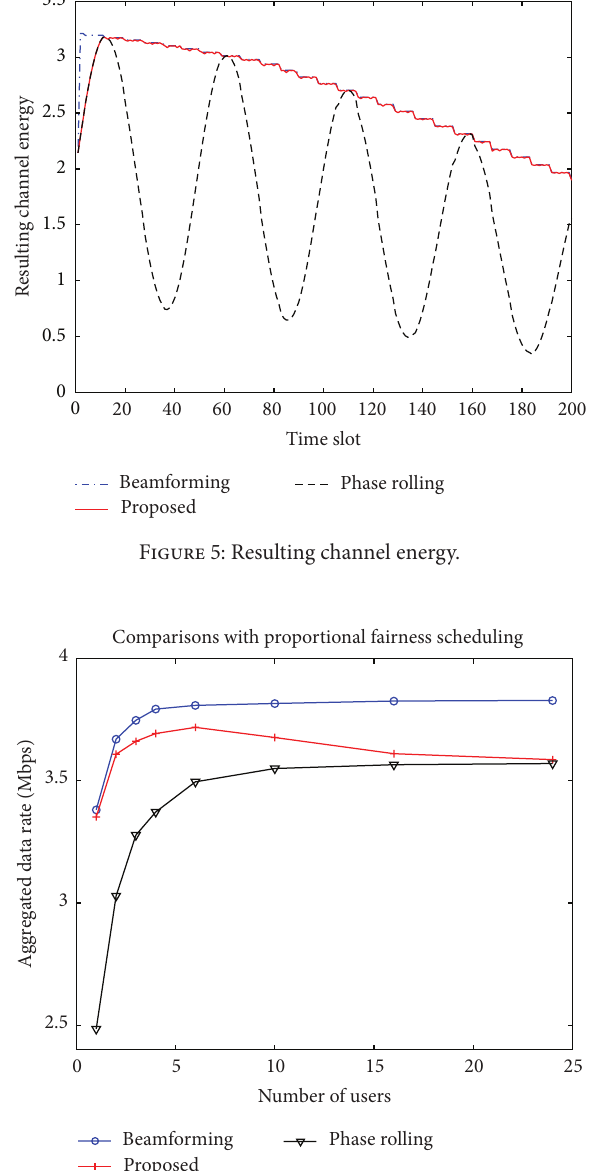
Figure 6: Data rates with the PF scheduling algorithm.